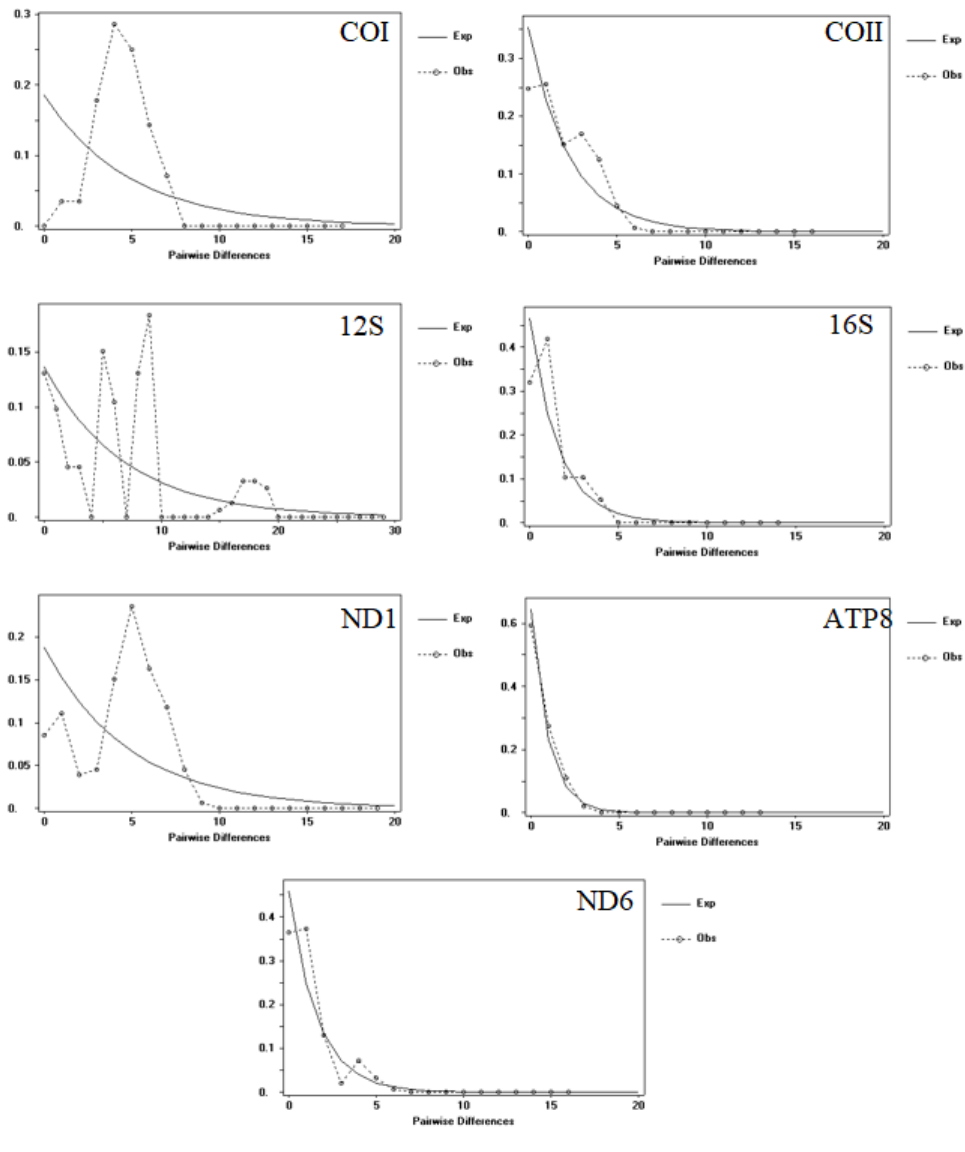
Figure 5. Graphs of the mismatch distribution of lineage A (a) and lineage B (b) based on mitochondrial genes COI, COII, ATP8, ND6, 12S rRNA, 16S rRNA and NDI. The abscissa represents the number of pairwise distances and the ordinate represents the number of observations. The lines represent the expected (smoothed) and observed (dashed) frequency of pairwise differences under the sudden lineage expansion model. Table 5. ANOVA results between and within lineages based on COI a gene fragment. d.f. = degrees of freedom, ST = Statistic, FST = genetic differences among population.